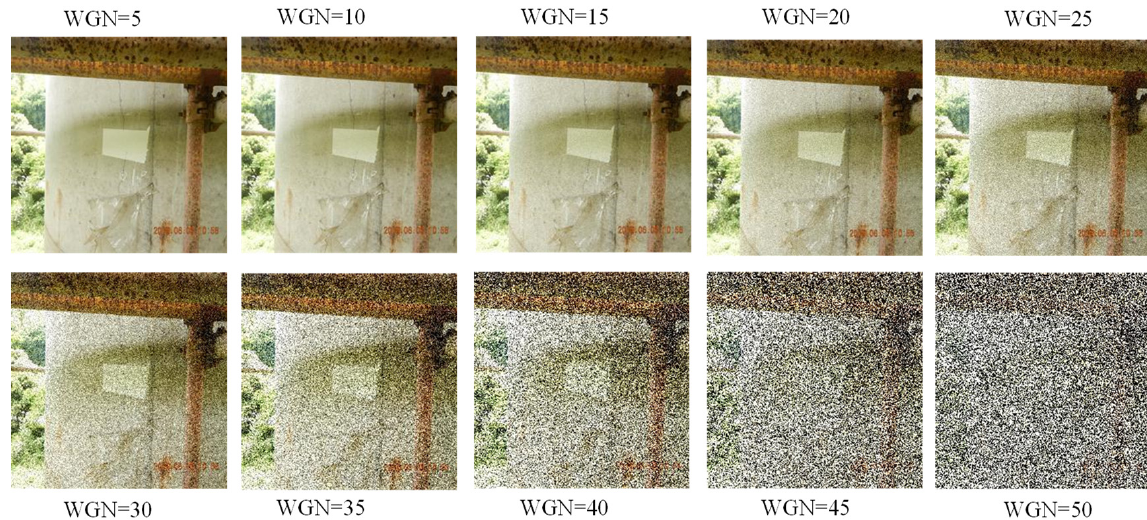
Figure 9. The CR image blurred by WGN.